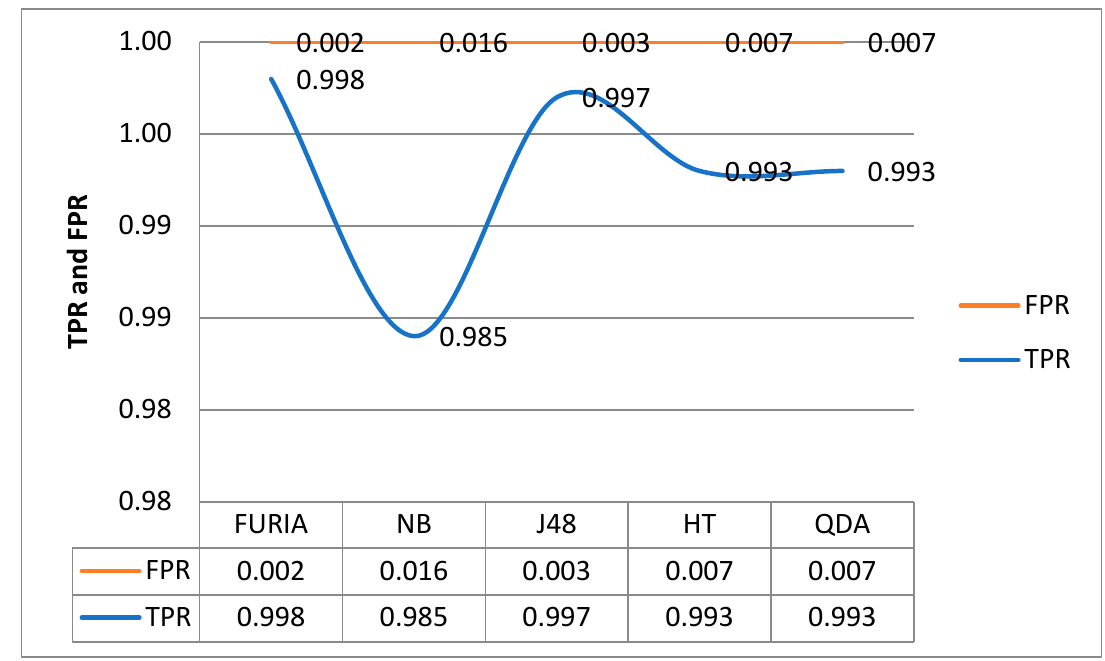
Figure 3. TPR and FPR analysis of each model.